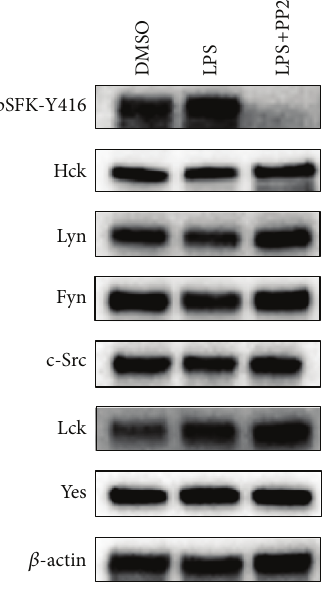
Figure 1: Expression of SFKs in PBMC of active BD patients. PBMC were isolated from total blood and 5 × 10 6 PBMC were cultured. The cells were treated with 10 𝜇 M PP2 for 1 h before 100 ng/mL LPS stimulationfor15min.DMSOtreatedcellswereusedascontrol.Cell lysates were examined for the presence of SFKs and activity of SFKs by Western Blotting. The lowest panel represents loading control ( 𝛽 - actin). The image shown represents a single representative example of five separate